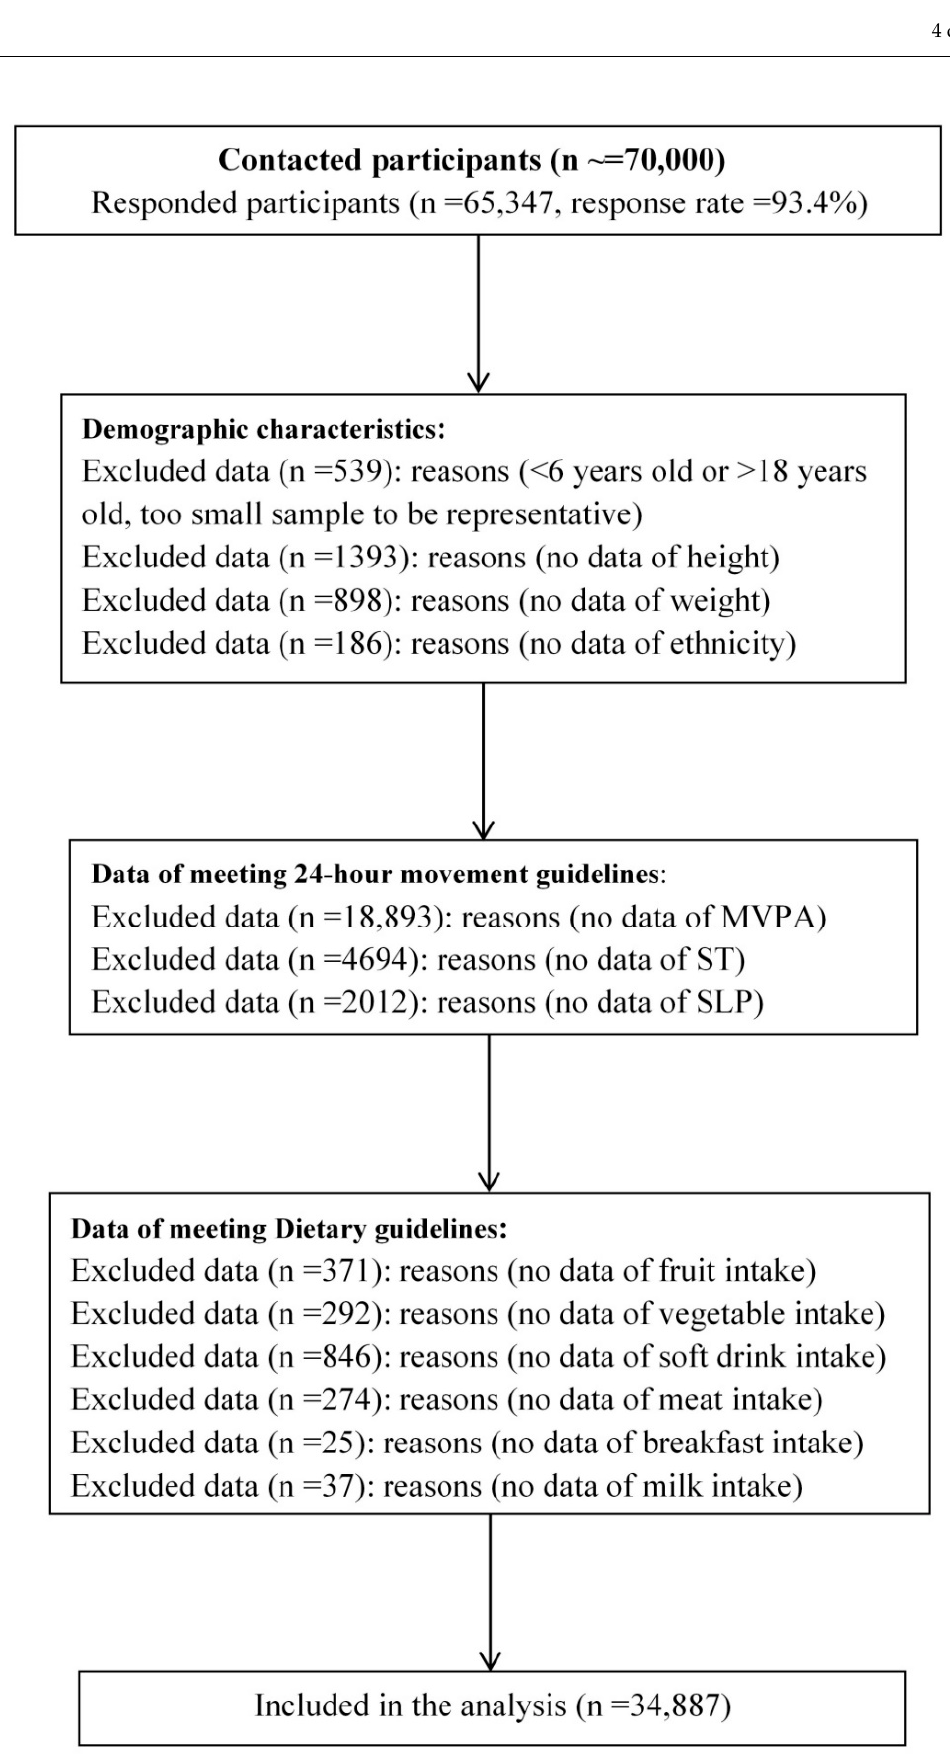
Figure 1. The procedure of obtaining final study sample in the present study. (MVPA = moderate-to-vigorous physical activity; ST = screen time; SLP = sleep duration).